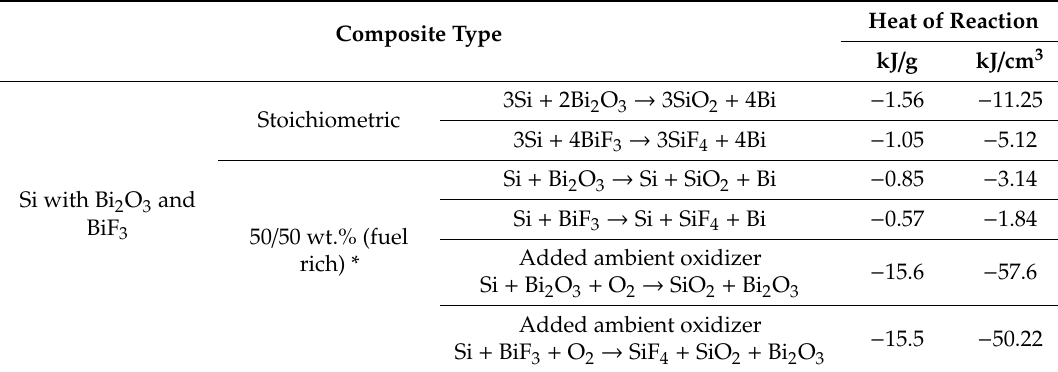
Table 1. Estimated heats of reactions involving Si with oxides and fluorides of Co and Bi for stoichiometric and fuel-rich (50 / 50 wt.%) composites reacting in inert and oxidizing